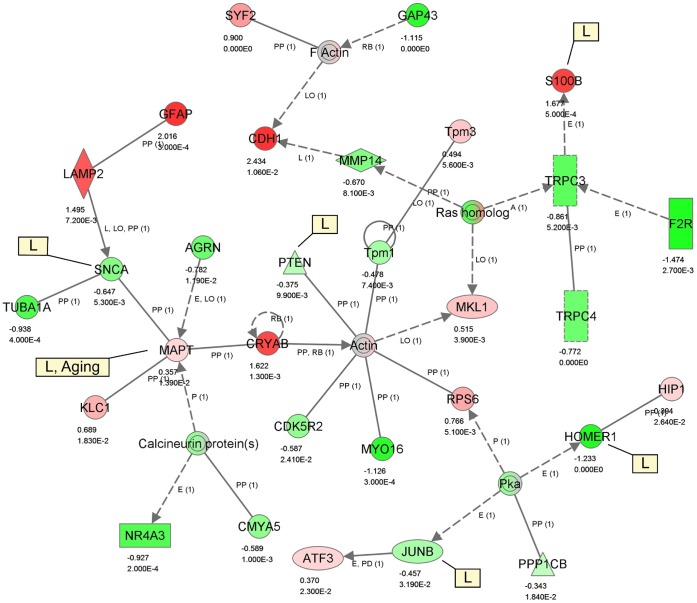
Network 3 from aged vs. young (AY) comparison.Major functions of this network are cellular assembly and organization, tissue development, and cell morphology. Each biological relationship (an edge) between two genes (nodes) is supported by at least one reference from the literature or curated information stored in the Ingenuity Knowledge Base. The intensity of the node color indicates the degree of up- (red) or down- (green) regulation observed in the AY comparison. The effect size and p-value for each gene is shown below the gene symbol. Edges are displayed with various labels that describe the nature of relationship between the genes (e.g. P for phosphorylation, PP for protein-protein binding, PD for protein-DNA binding, A for activation, E for expression, L for proteolysis, LO for localization, RB for regulation of binding). Any specific findings for a gene whether it is associated with aging (A), learning (L), and/or spatial learning (SL) is presented inside a rectangle beside that gene.